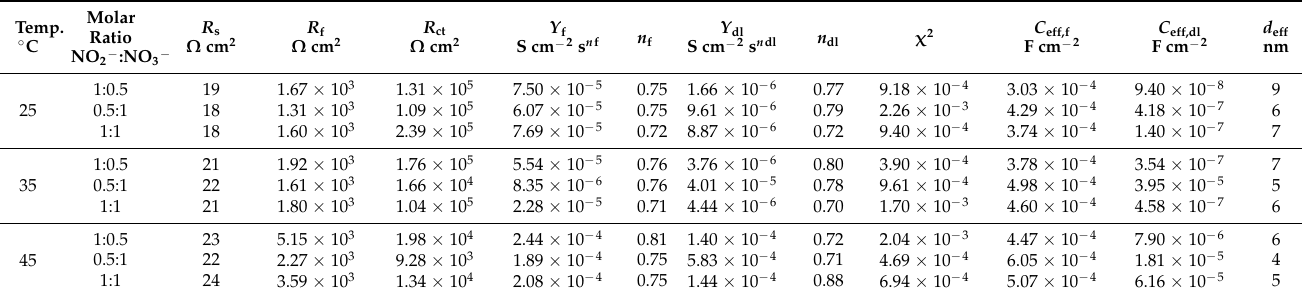
Table 2. EIS parameters obtained from steel rebars immersed in SCPS with 0.6 M NaCl with and without corrosion inhibitors in molar ratios of 0.5:1, 1:1, and 1:0.5 for NaNO 2 :NaNO 3 at 25, 35, and 45 ◦